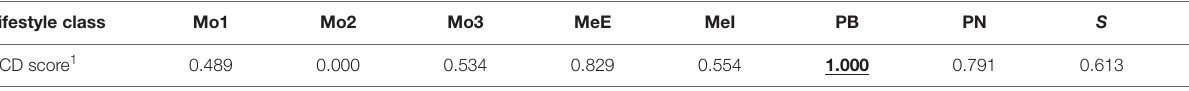
TABLE 3 | Summary of predicted CATAStrophy lifestyle classifications for N. psidii . Lifestyle class